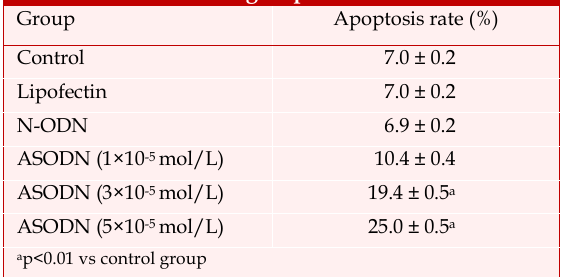
Apoptosis rate of gastric cancer cells in different